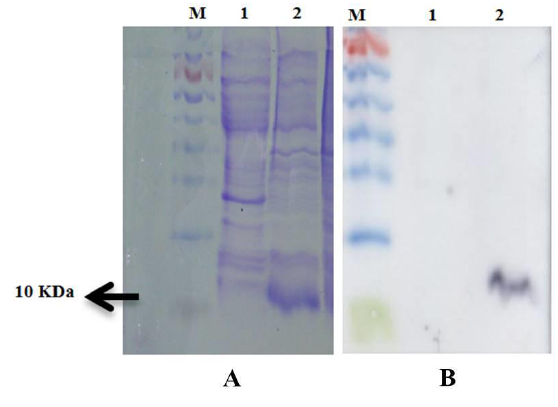
Fig. 1. SDS-PAGE and western blot showing induction of recombinant protein : (A) BL21 (DE3) cells transformed with pET26b (+) vector containing tfgd2 gene were grown up to 0.6-0.8 OD and induced with IPTG. After harvesting cells total protein was extracted and analyzed on 15% SDS-PAGE., 1= Non-induced protein extraction, 2= Induced protein expression, M= Protein marker; (B) Western blot of recombinant protein with anti-His., 1= Non-induced protein extraction, 2= Induced protein expression, M= Protein marker.